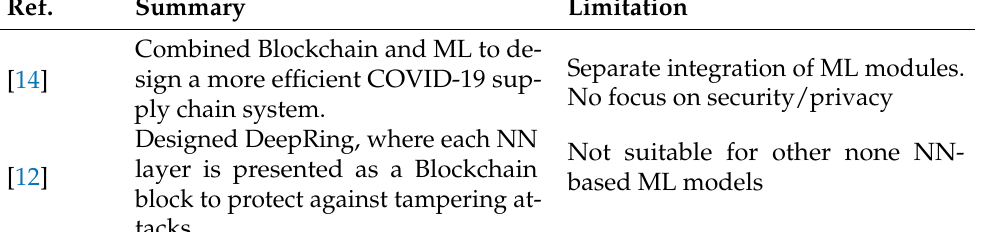
Table 1. Summary of existing solutions incorporating ML with Blockchain and their limitations.